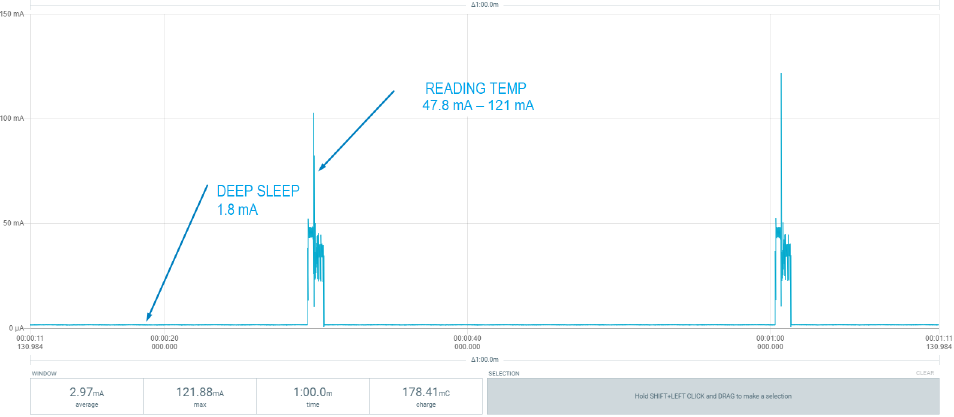
Figure 10. ESP32 node: Low-power mode (Deep Sleep) and sensor reading.